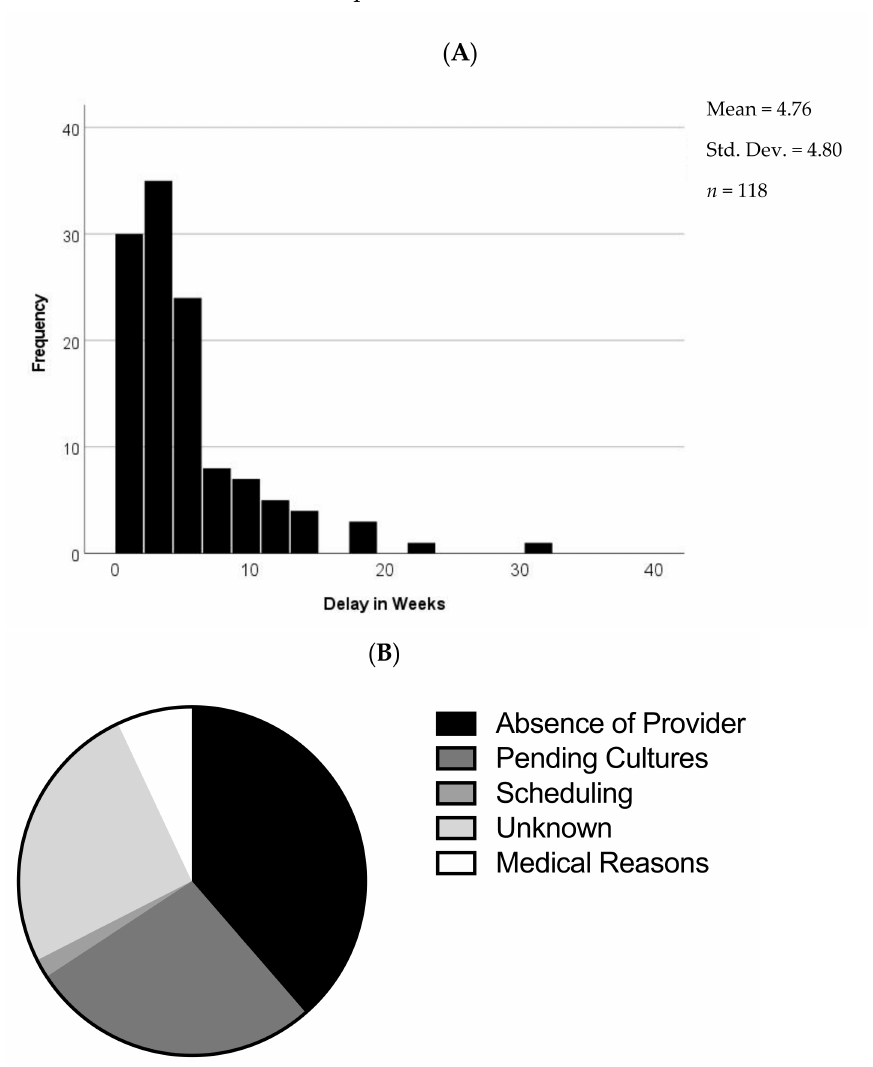
Figure 2. Delay in LARC Placement. ( A ) Length of delay; ( B ) reasons for